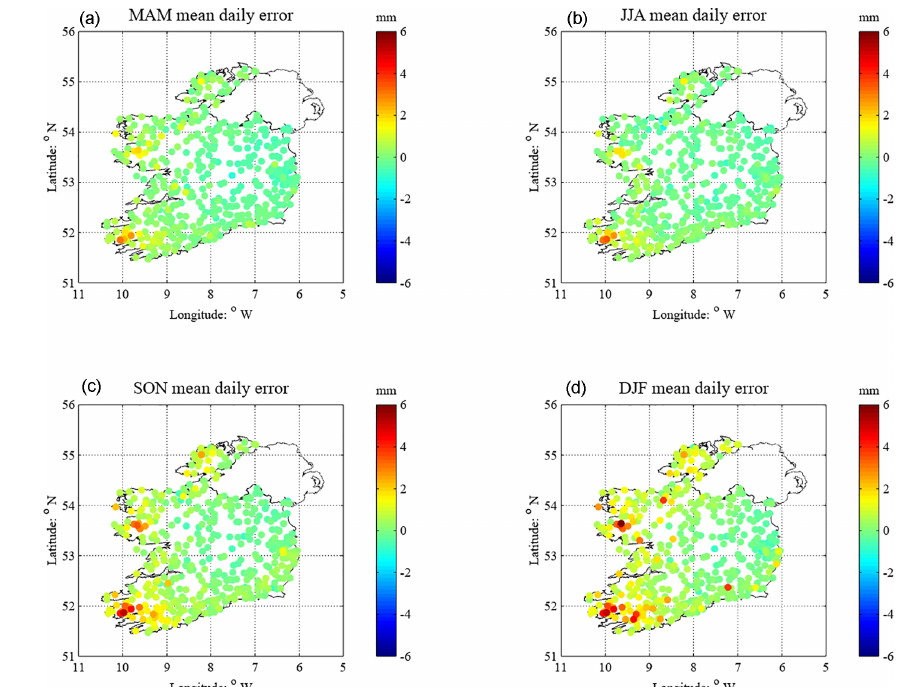
Figure 8. COSMO-CLM daily precipitation error (by season) for the period 1981–2015, found utilising Met Éireann daily station data for: